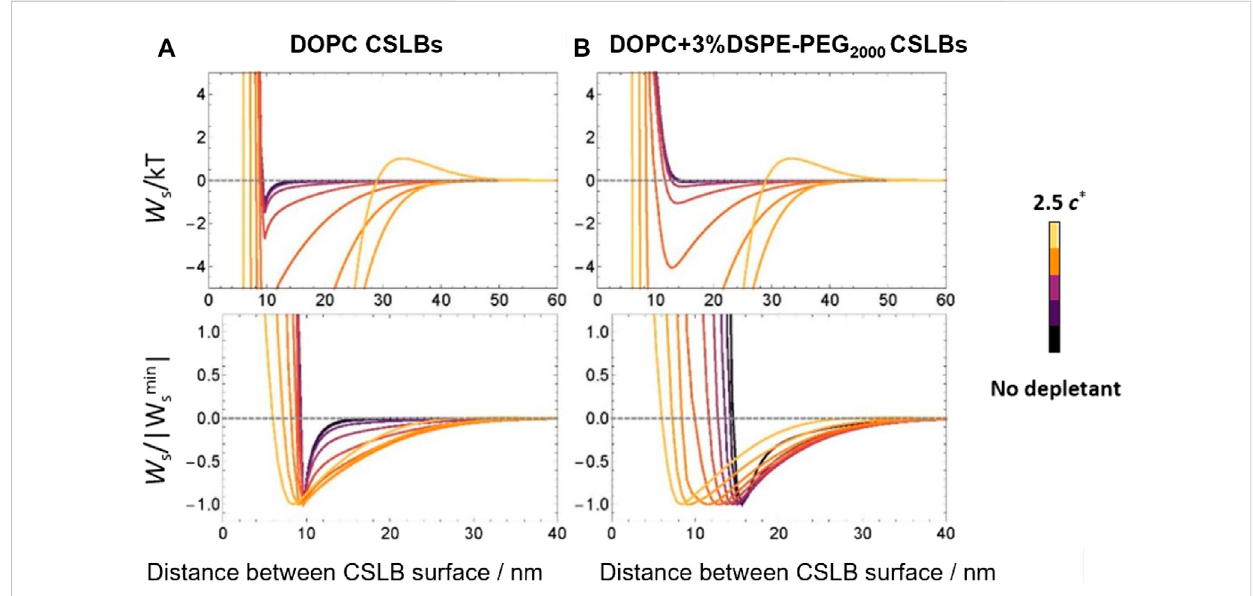
FIGURE 4 The impact of 100 kDa PEG depletion on the strength of interaction between (A) DOPC and (B) DOPC+3%DSPE-PEG 2000 , over the concentration range from 0 (black) to 2.5 c* (yellow) as computed using numerical SCFT lattice computations. Note — legend does not follow a linear